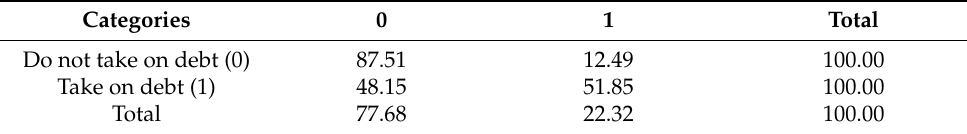
Table 5. Transition probabilities from one period to the next for debt-taking behaviour.